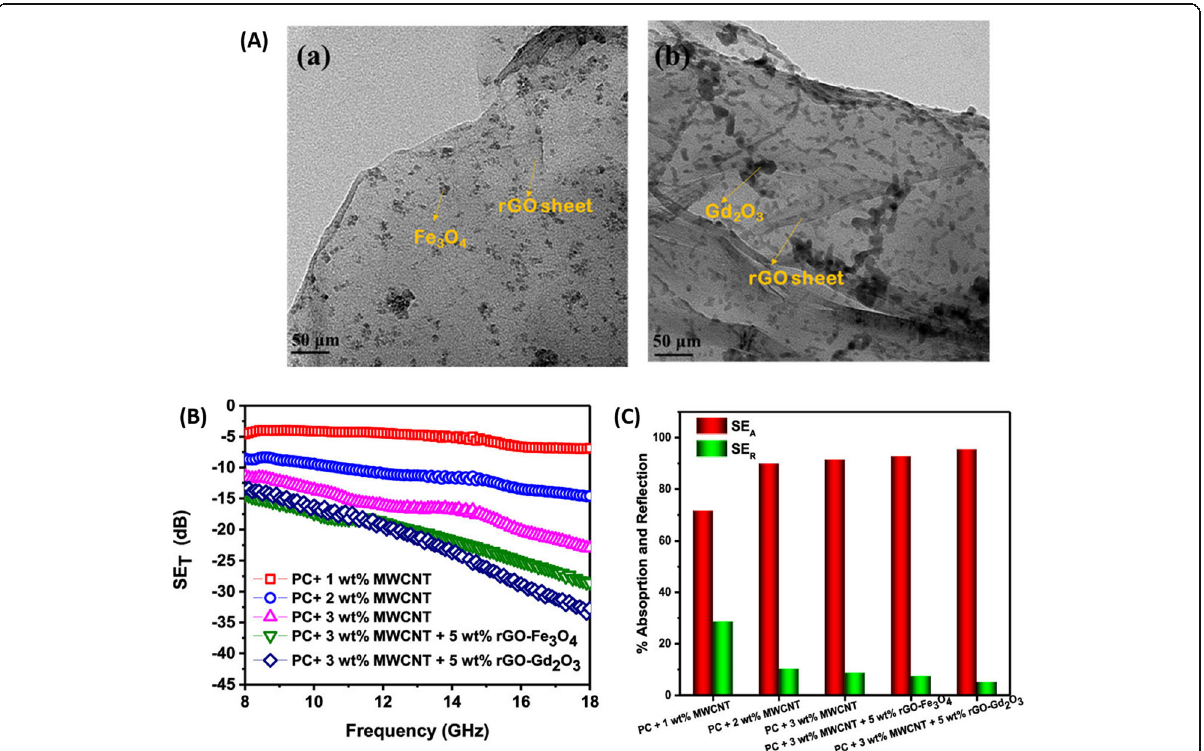
Fig. 9 ( A ) Transmission electron micrographs of ( a ) rGO-Fe 3 O 4 and ( b ) rGO-Gd 2 O 3 ; ( B ) SE T vs. frequency; ( C ) % Absorption and reflection at 18 GHz. Adapted with permission from Bose et al. [80], copyright 2019 American Chemical